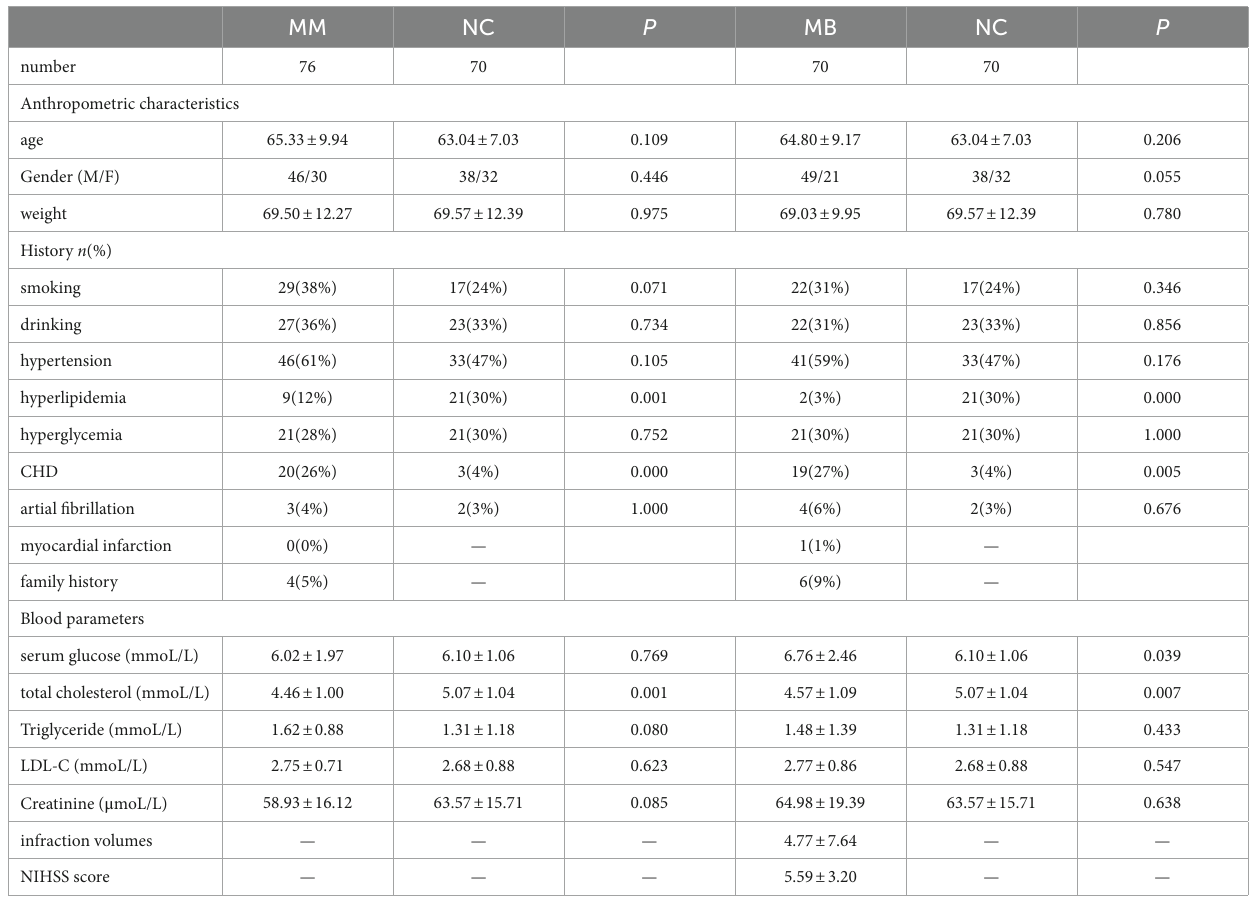
TABLE 1 Clinical and demographic characteristics of